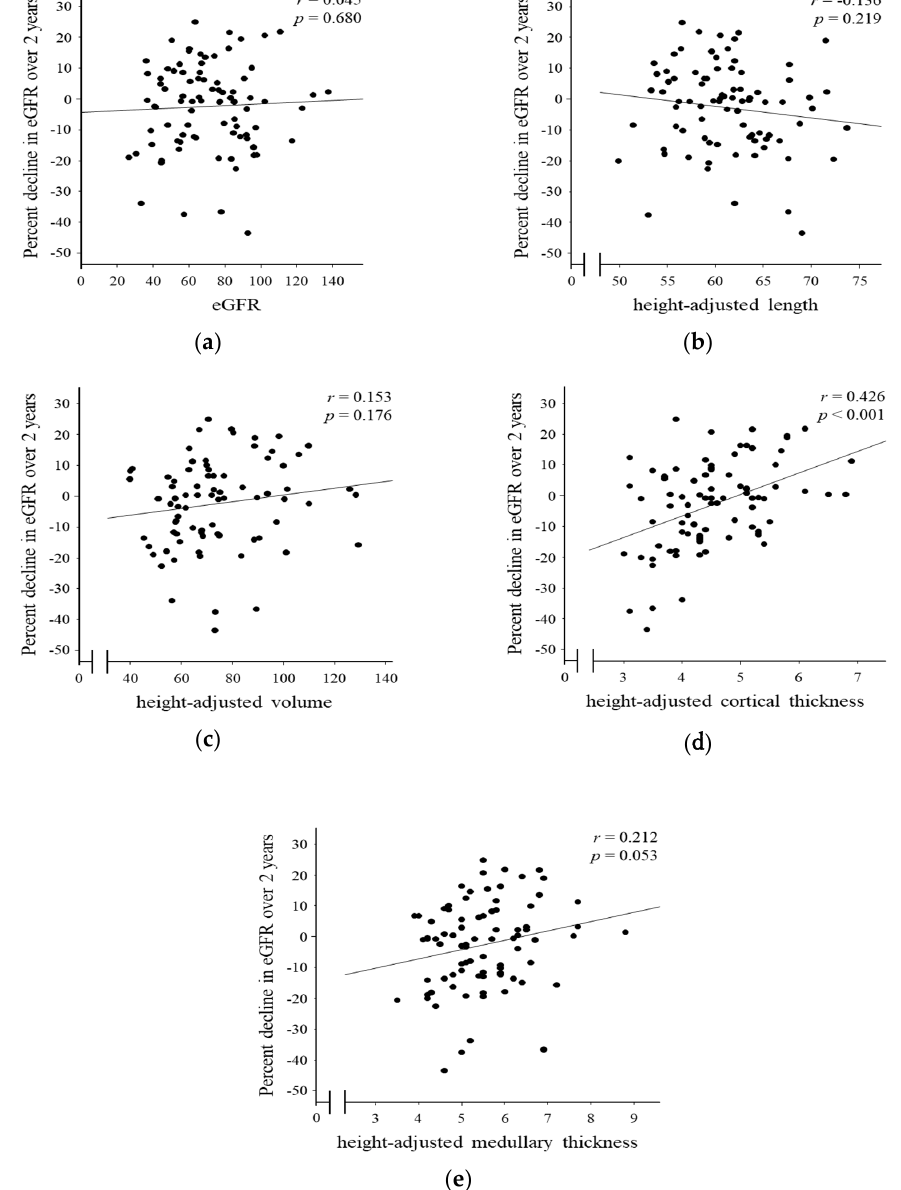
Figure 3. Correlation of morphological parameters by ultrasonography and decline in renal function over 2 years. Scatter plots comparing the decline in eGFR and baseline eGFR ( a ), kidney length ( b ), volume ( c ), cortical thickness ( d ) and medullary thickness ( e ). eGFR, estimated glomerular filtration rate.